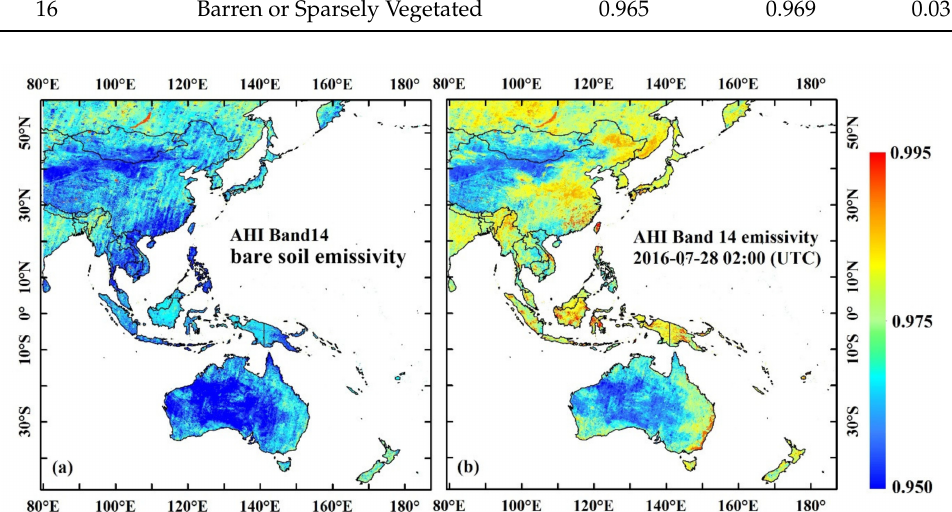
Figure 2. ( a ) The emissivity of the ground (bare soil emissivity) and ( b ) the emissivity of the land surface on 28 July, 2016, 02:00 UTC for AHI band